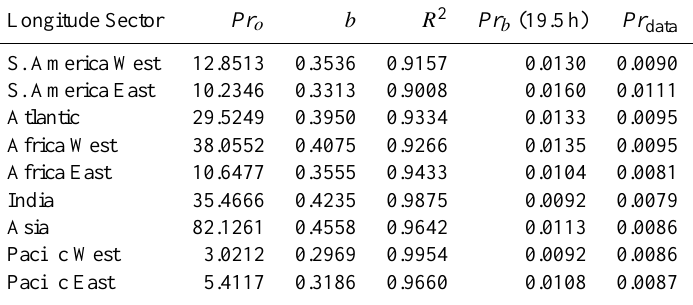
Table 2. Results from the least square fit of the exponential trend line Pr b (h) = Pr b exp ( − bt) to data of Fig. 8b. A trend line is most reliable when its R 2 value (0 ≤ R 2 ≤ 1) in the fourth column is at or near 1. The column Pr data lists the values of the bin [18:00–21:00LT) of Fig.